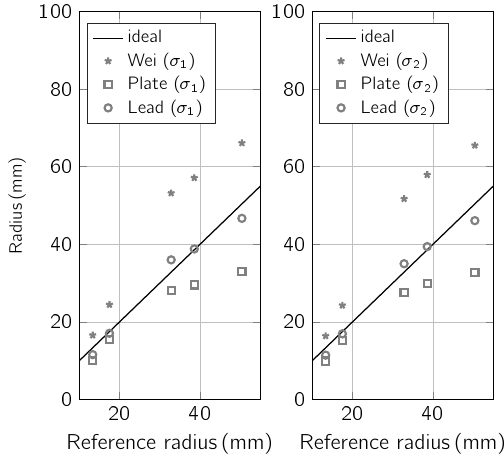
Figure 6: Estimated radii using the classical Wei, the plate, and the lead ACM compared to the known radii of the cylinders (Data). Left: conductivity of saline solution (cid:27) 1:69 S/m, right: conductivity of saline solution 1 = (cid:27) 0:62 S/m. 2 = heart failure. Compared to the Wei ACM, the biases are reduced by a factor of ten if the lead ACM is applied.